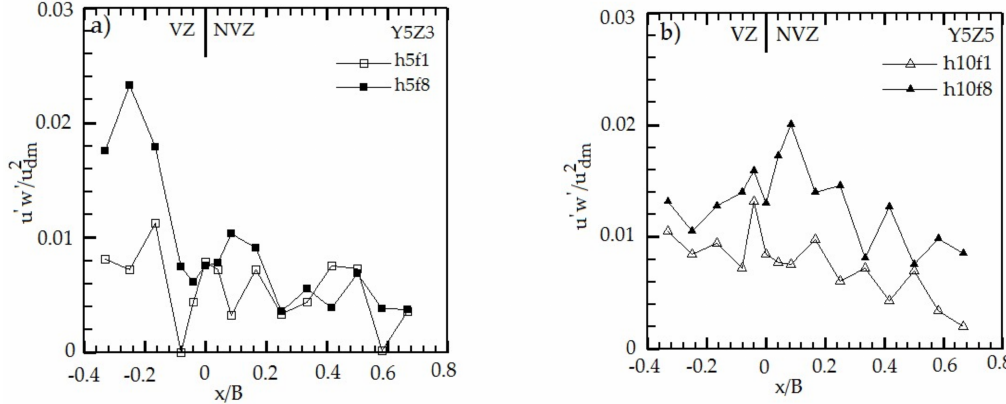
Figure 16. Non-dimensional Reynolds stresses along Y5 section for all cases; ( a ) h v = 0.05 m; ( b ) h v = 0.1